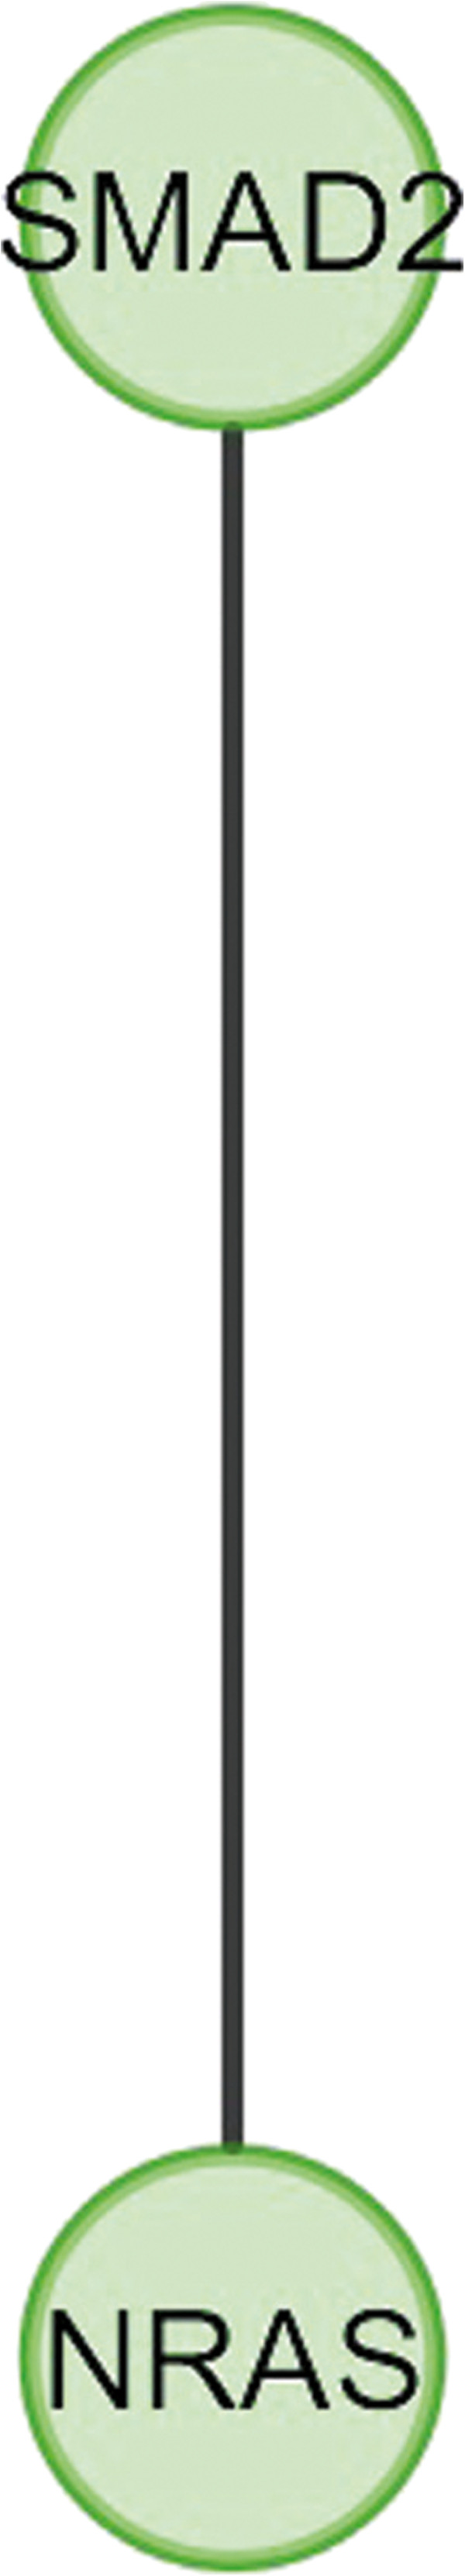
Overlapping module in cancer condition of liver.